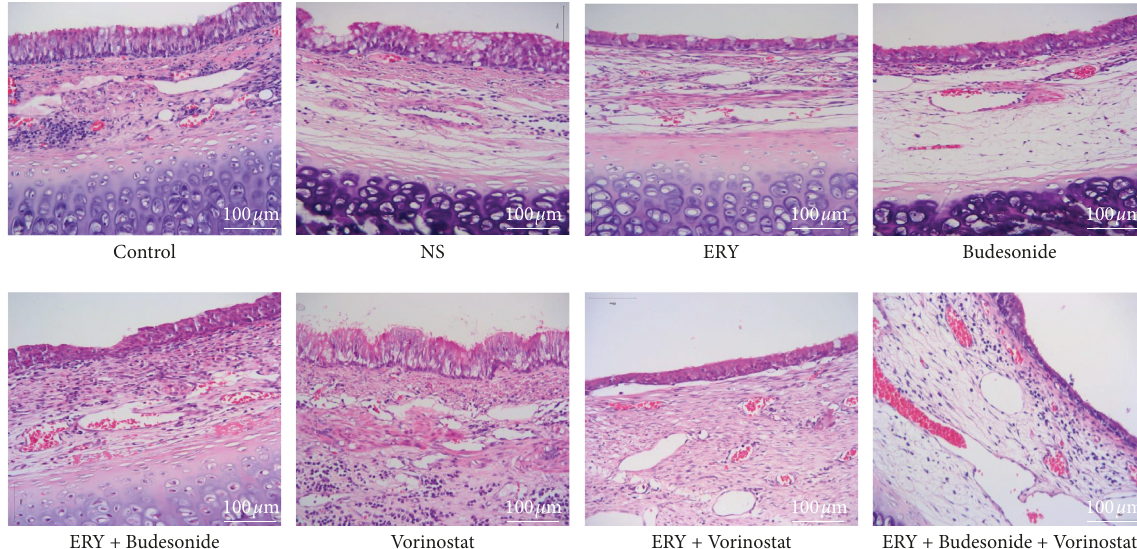
Figure 2: HE staining results. Control: rabbit tracheal stenosis model without treatment; NS: rabbit tracheal stenosis model treated with penicillin; ERY: rabbit tracheal stenosis model treated with erythromycin; Budesonide: rabbit tracheal stenosis model treated with budesonide; Vorinostat: rabbit tracheal stenosis model treated with